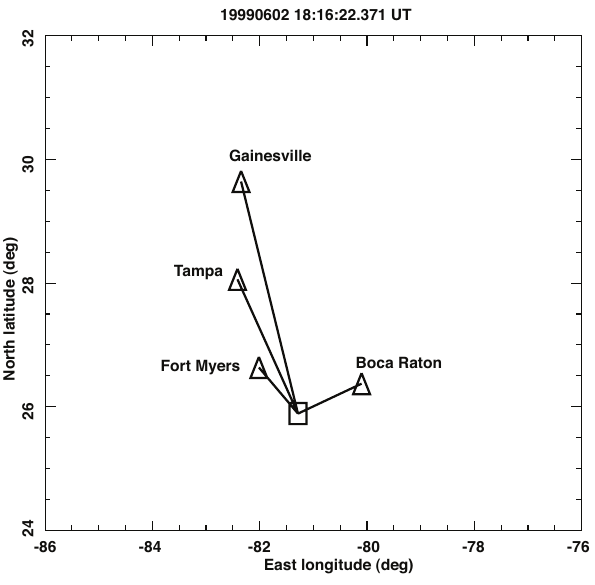
Fig. 2. Map of the four participating LASA stations (triangles) in Florida, connected by baselines (black lines) to the sferic source location (square), for a single example of a Narrow Bipolar pulse. This is a daytime example, when PDD data would not be avail- able, but is meant to show the characteristics of the NBE sferic on recorded at multiple ranges.